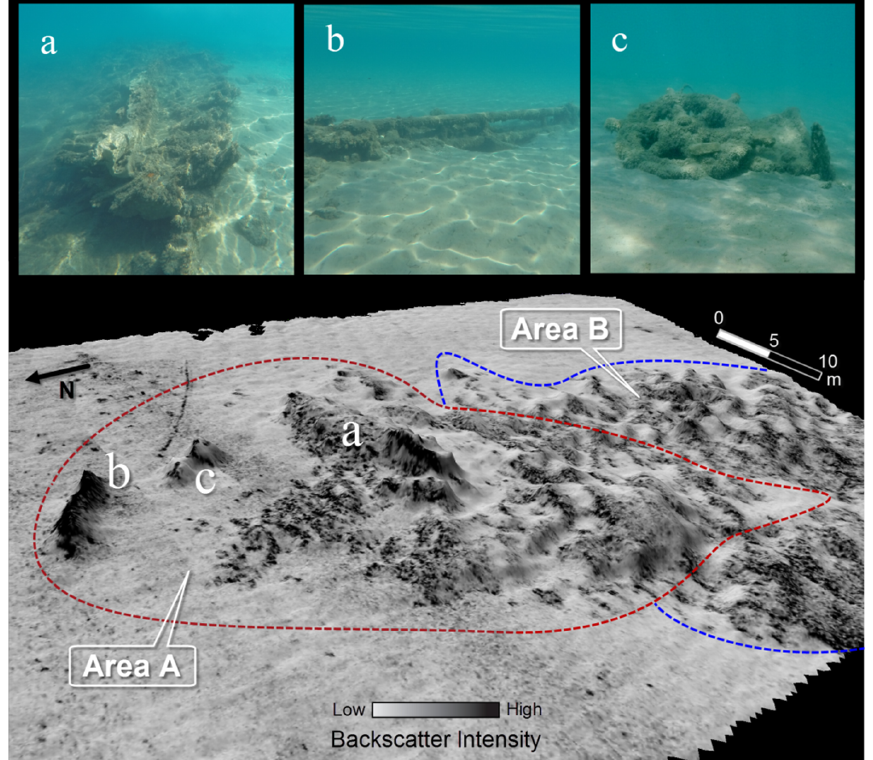
Figure 4. A 3D view of backscatter intensity over ‘wreck site 1’ draped over bathymetry. High backscatter returns ( area A —outlined in red) correspond to the wreck mound ( a ) and archaeological material ( b ) elongated gunwale-like feature; ( c ) steering wheel. Medium and high backscatter returns (area A—outlined in red), south and west of the mound, correspond to accumulated sediments. High backscatter returns further south ( area B —outlined in blue) correspond to accumulated sediments in seagrass meadows. Length scale and north arrow refer to the image centre.